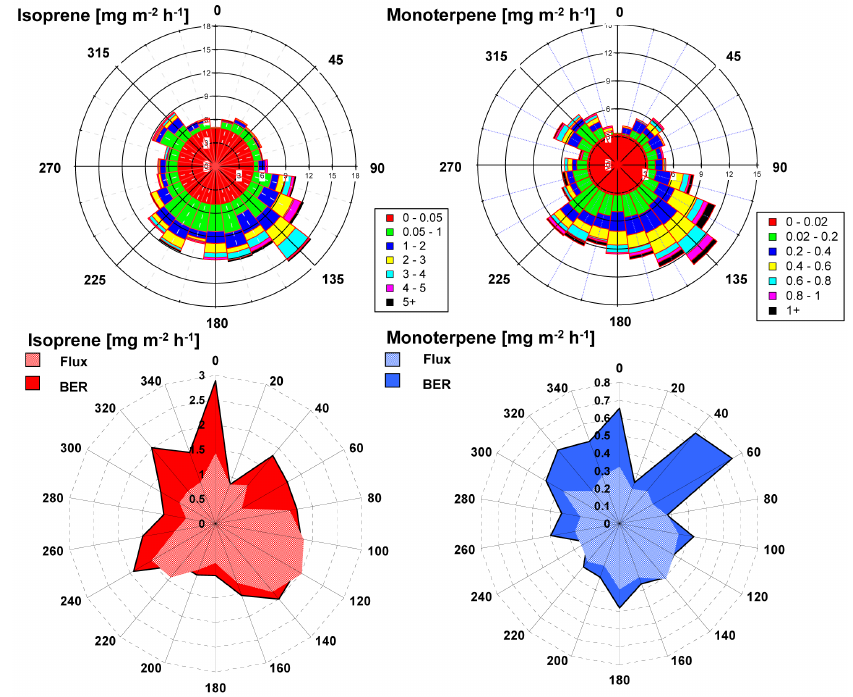
Fig. 7. Wind roses of isoprene and monoterpene fluxes (top) measured during the two OP3 campaigns. The bottom plots show the same raw flux data (light shading) and the base emission rate (solid shading) which is the raw flux normalised to standard conditions (30 ◦ C (Canopy temperature), 1000µmolm − 2 s − 1 ) using the light and temperature algorithms from the MEGAN model (Guenther et al.,